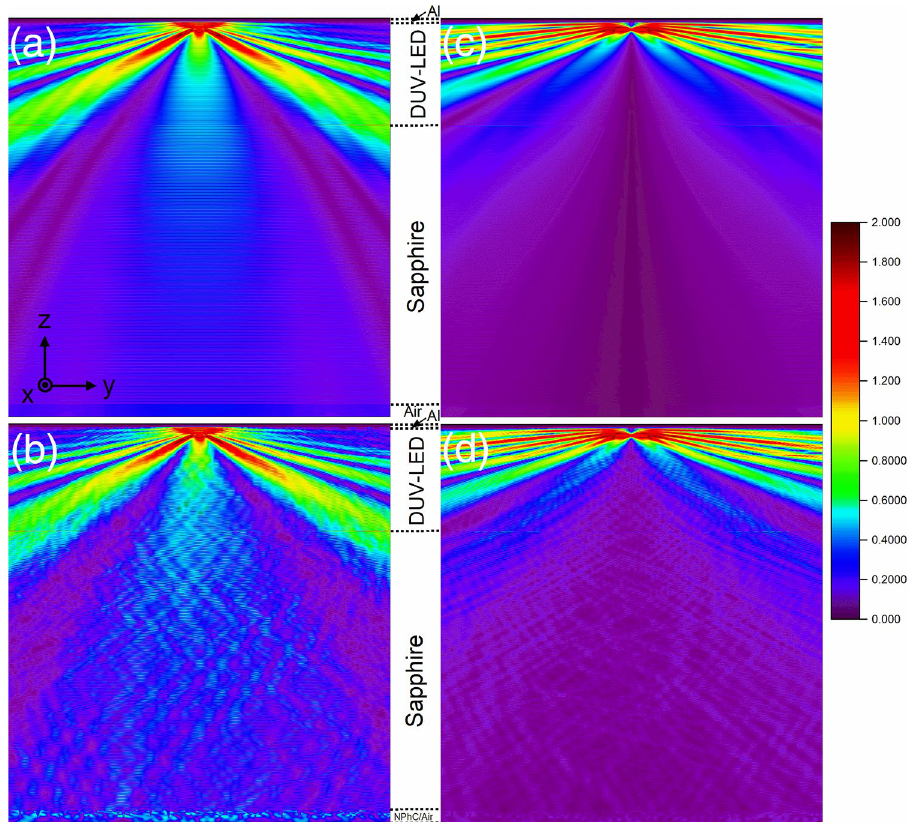
Figure 7. The cross-sectional view of the EFI for TE ( a , b ) and TM ( c , d ) modes for the conventional DUV- LED ( a , c ) and the DUV-LED device with NPhC structure ( b , d ), respectively. The NPhC, sapphire, DUV-LED, and Al layers are indicated. The color bar on the right shows the normalized